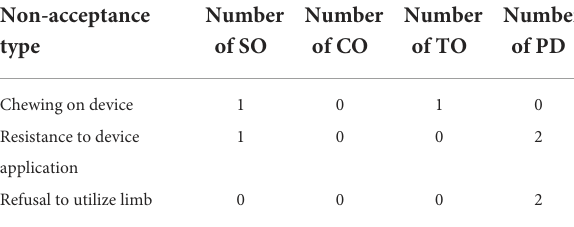
TABLE 7 Non-acceptance types by patient